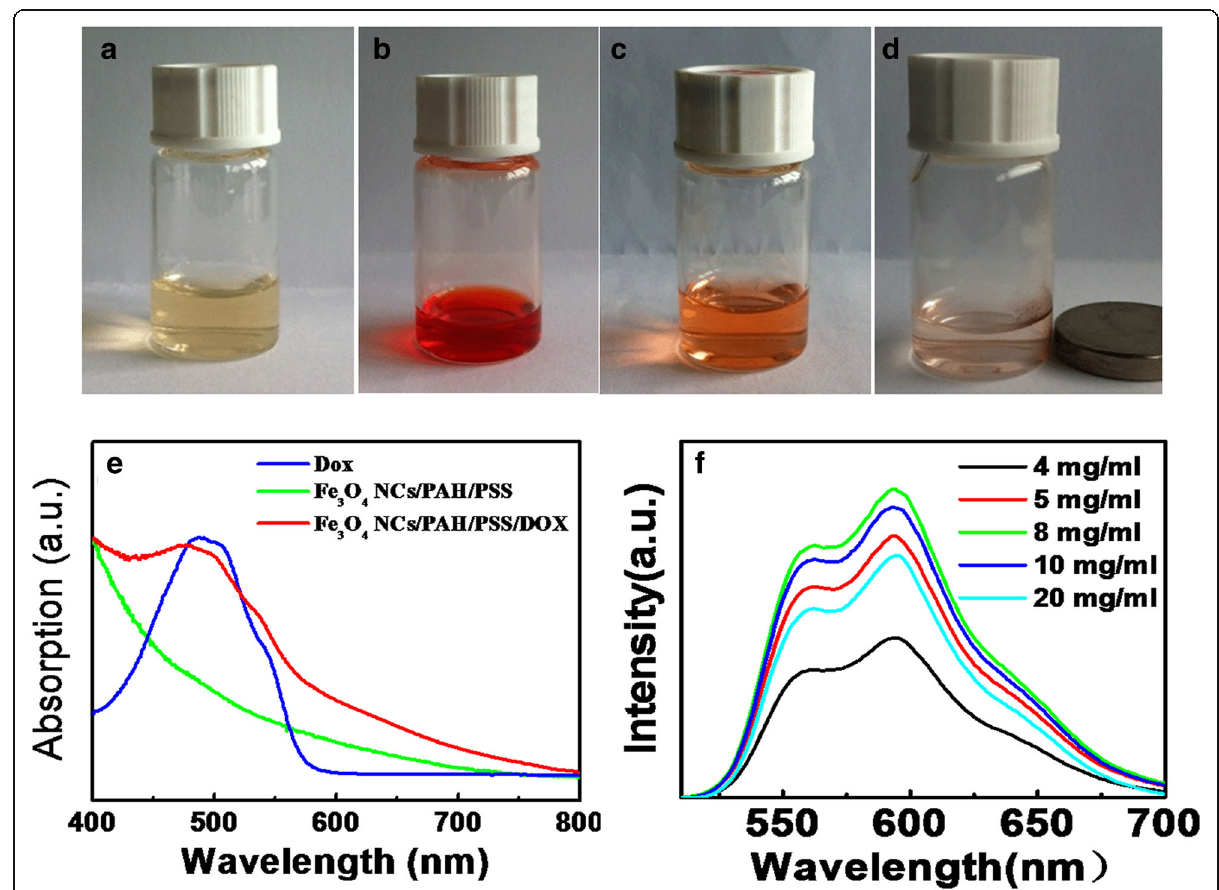
Fig. 4 Photographs ( a – d ) of the different absorbed stages of DOX on the Fe 3 O 4 NC/PAH/PSS hybrid nanostructures. The UV – vis absorption spectra ( e ) of DOX, Fe 3 O 4 NC/PAH/PSS, and Fe 3 O 4 NC/PAH/PSS/DOX hybrid nanostructures. The luminescence spectra ( f ) of Fe 3 O 4 NC/PAH/PSS/ DOX hybrid nanostructures when the different concentration of DOX was added into the Fe 3 O 4 NC/PAH/PSS hybrid nanostructure